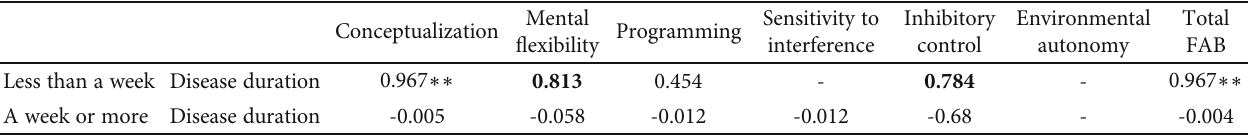
Table 6: Partial correlation between disease duration and FAB scores in “ less than a week ” and “ a week or more ” groups of JME patients, controlling for age, sex, and multiple